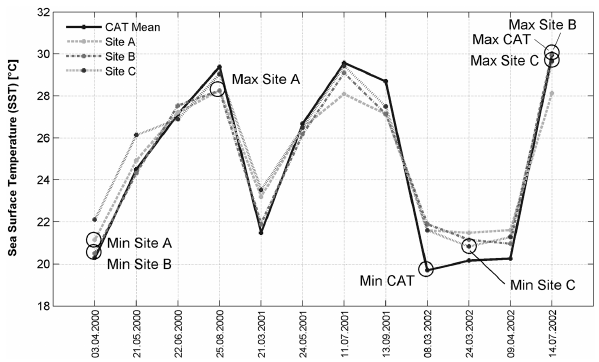
Figure 8. SST over time for sites A–C and the mean value of the central area (CAT) as reference. The respective minimum and max- imum values of each site are